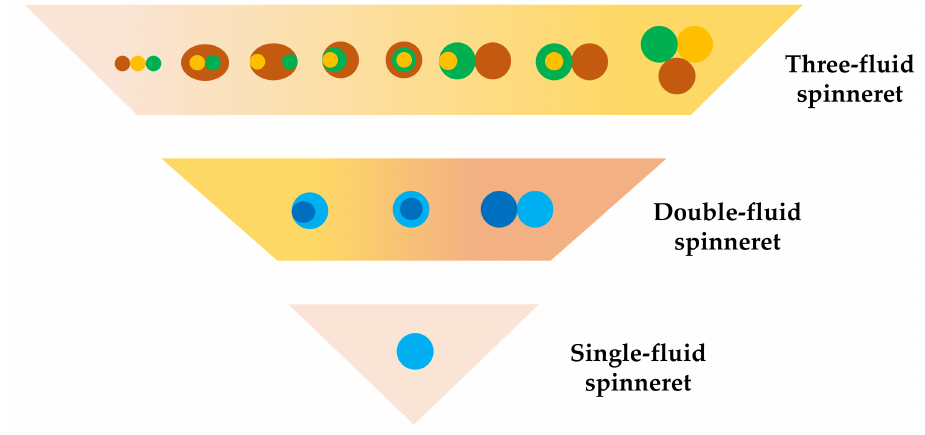
Figure 7. Types of spinnerets in